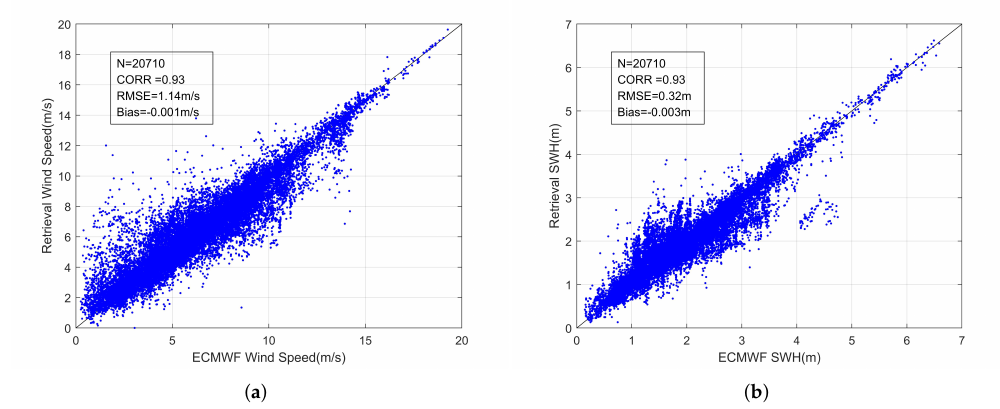
Figure 11. Retrieved results. ( a ) retrieved wind speed after adding SWH. ( b ) retrieved SWH after adding wind speed. The black lines are ‘y = x’ for